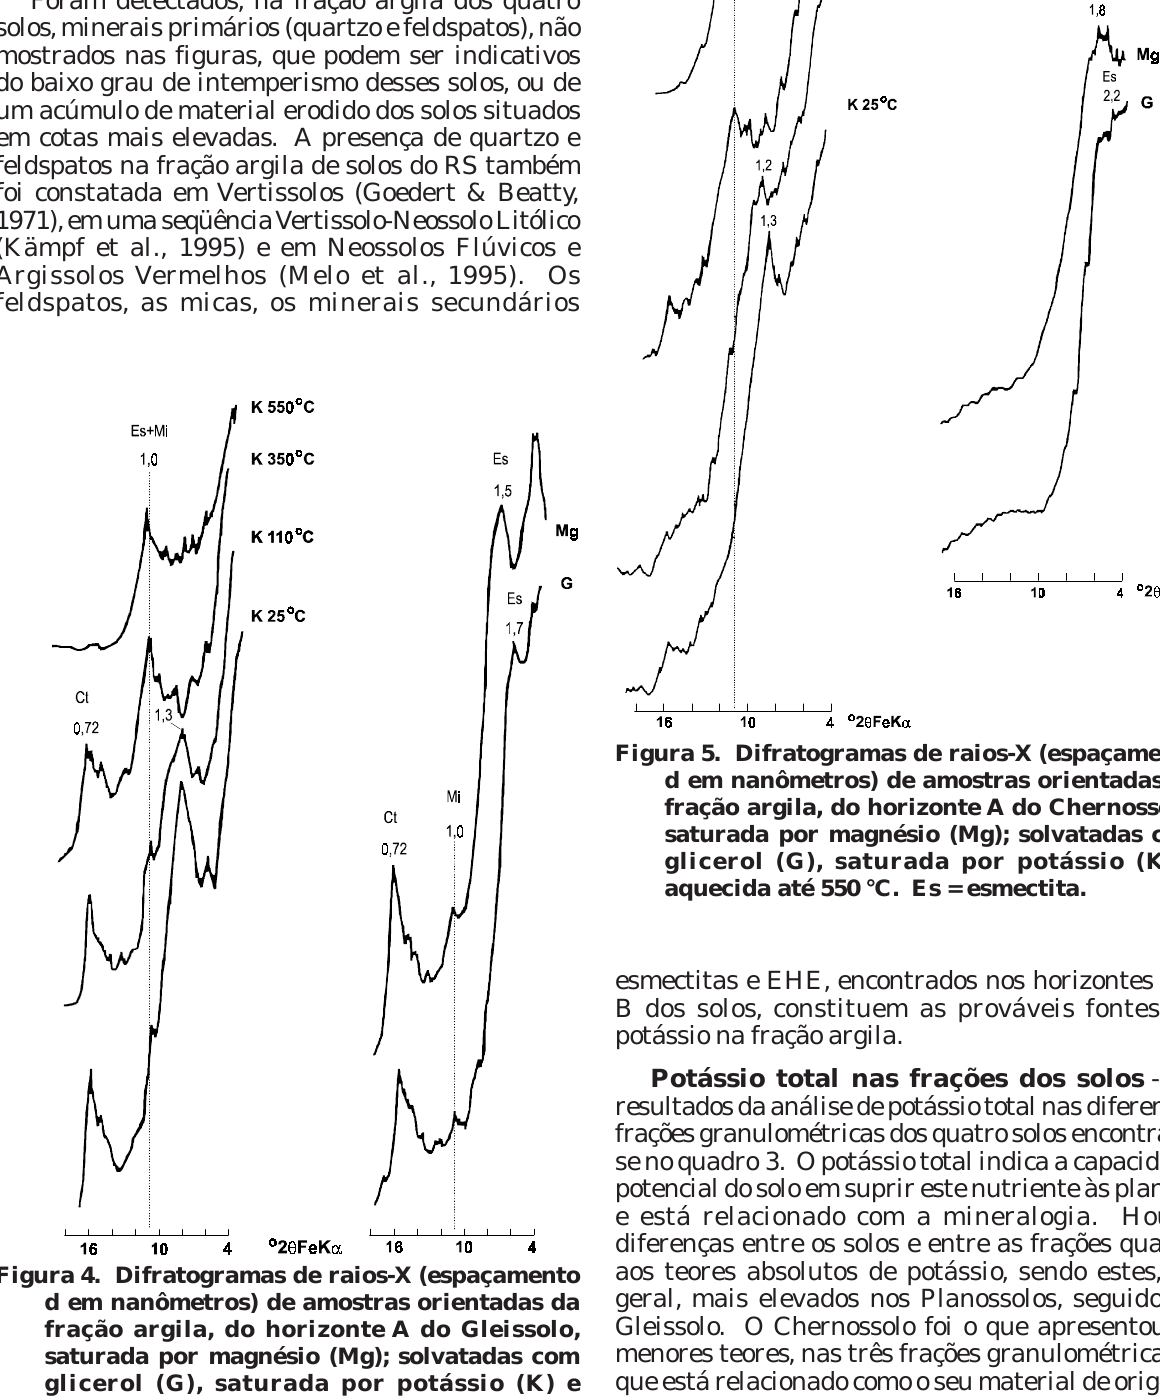
Figura 4. Difratogramas de raios-X (espaçamento d em nanômetros) de amostras orientadas da fração argila, do horizonte A do Gleissolo, saturada por magnésio (Mg); solvatadas com glicerol (G), saturada por potássio (K) e aquecida até 550 °C. Mi = mica, Es = esmectita, Ct = caulinita.